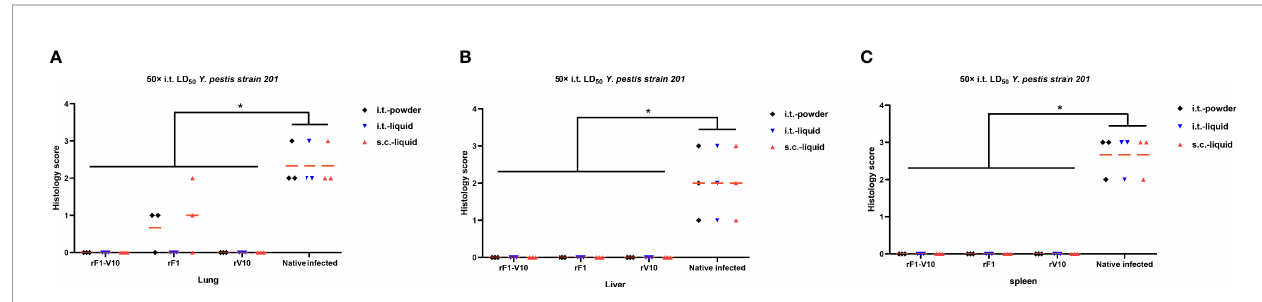
FIGURE 7 | Pathological lesions in the tissues of mice euthanized at 2 days post 50× LD 50 Y. pestis strain 201 i.t. challenge. Tissue from lungs, livers, and spleens were collected from three mice per group (rF1-V10, rF1, and rV10 with different formulations via i.t. or s.c. routes), fi xed in formalin, embedded in paraf fi n, and stained with HE. Pathological scores of (A) lung tissue; (B) liver tissue; and (C) spleen tissue are presented. Tissue sections were evaluated by a trained pathologist according to the following scores: 0, no pathological lesions; 1, minimal; 2, mild; 3, moderate; 4, severe. The degree of pathological lesions was related to the distribution and severity of lesions as follows: (I) edema; (II) tissue parenchymatous lesions, such as congestion and hemorrhage. Experiments were performed twice independently with similar results. Data are expressed as the mean ± SD (n = 3) for data collected from one representative experiment. * P <